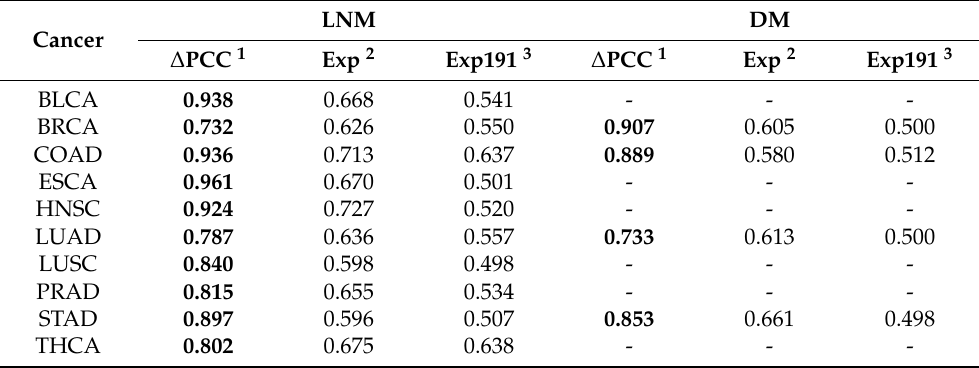
Table 4. Comparison of three types of features in predicting lymph node metastasis (LNM) and distant metastasis (DM) with respect of AUC in independent testing. All the values are the average of 10 runs. Bold values indicate best values. -: no result.